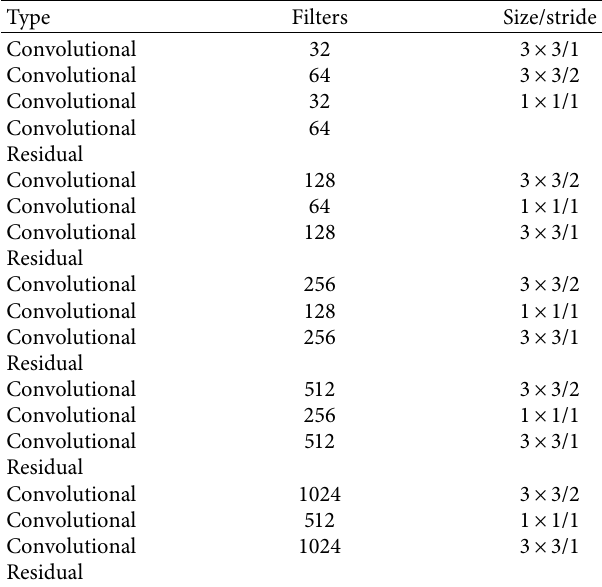
Table 1: The backbone of